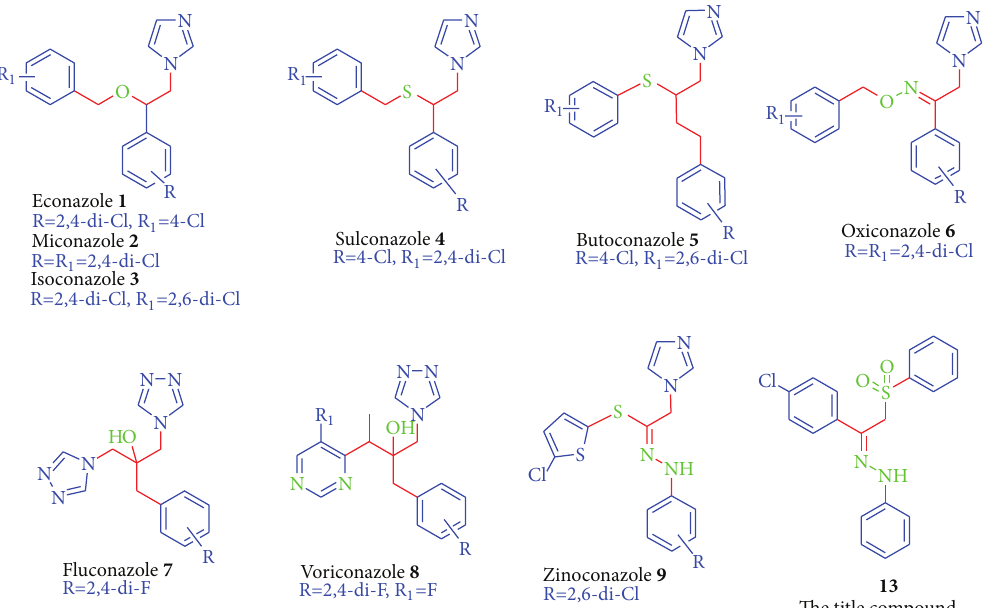
Figure 1: Structures of antifungal drugs 1 – 9 and the title compound 13